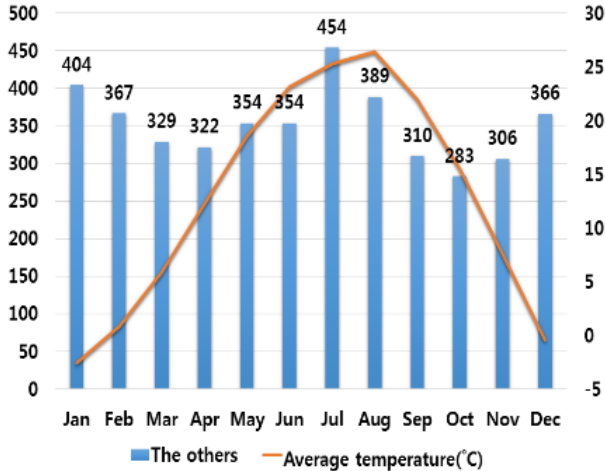
Figure 5. Correlation between the number of fires caused by other causes and the average temperature on a monthly basis.